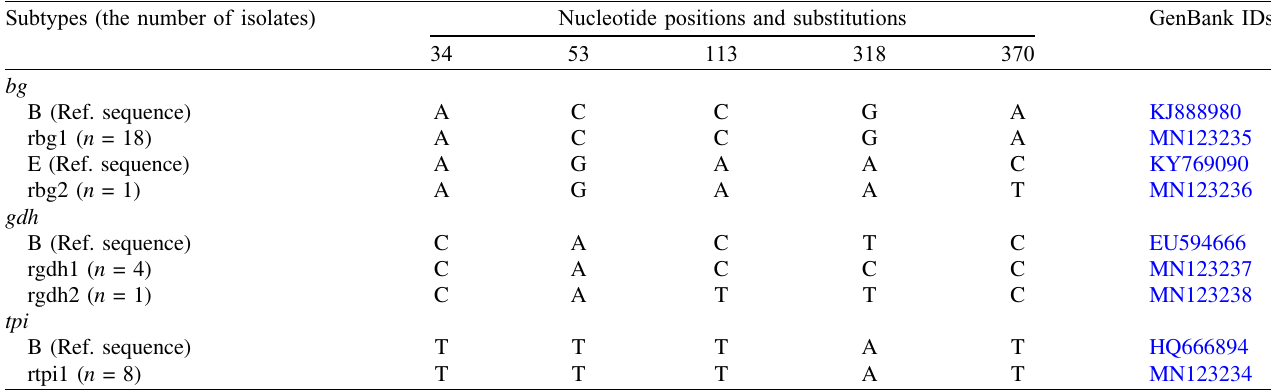
Table 2. Intra-assemblage substitutions in bg , tpi and gdh sequences within assemblage B and assemblage E. Subtypes (the number of